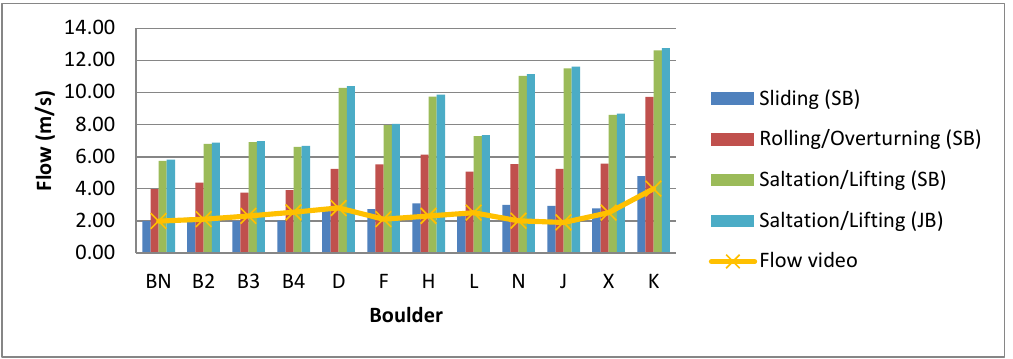
Figure 11. Flow needed to move the boulders assessed with Nandasena et al. [32] relationships and flow obtained by video editing.